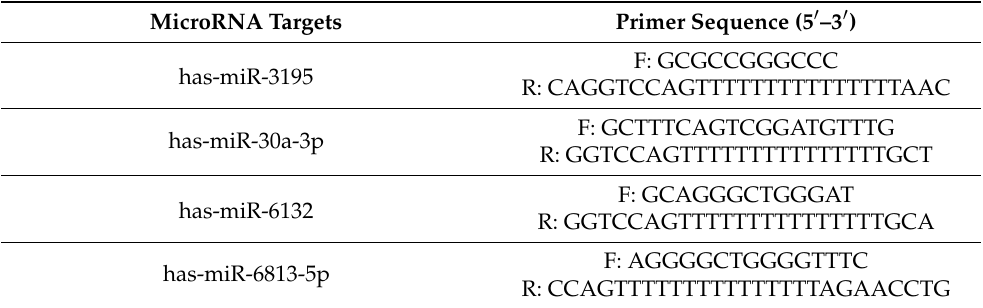
Table 3. List of miRNA-specific primers used in the